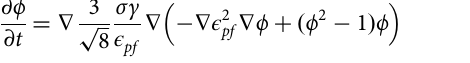
Fig. 3a. In the fi rst step, the mixture dynamics in a region fi lled with randomly distributed silver and gold are simulated. This step